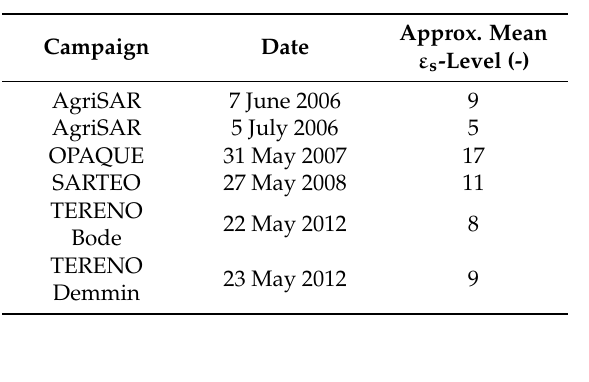
Table 1. Approximated mean dielectric level of soil from in situ measurements of the different